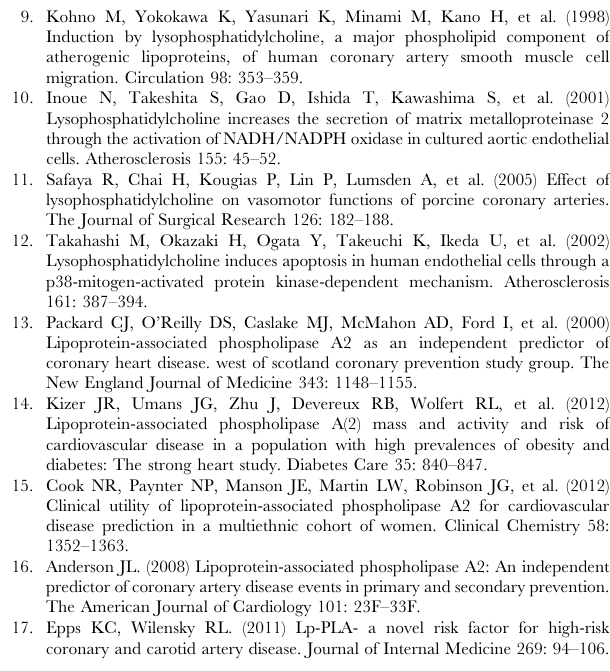
Table S1 Standardized differences of low and high Lp- PLA2 activity after